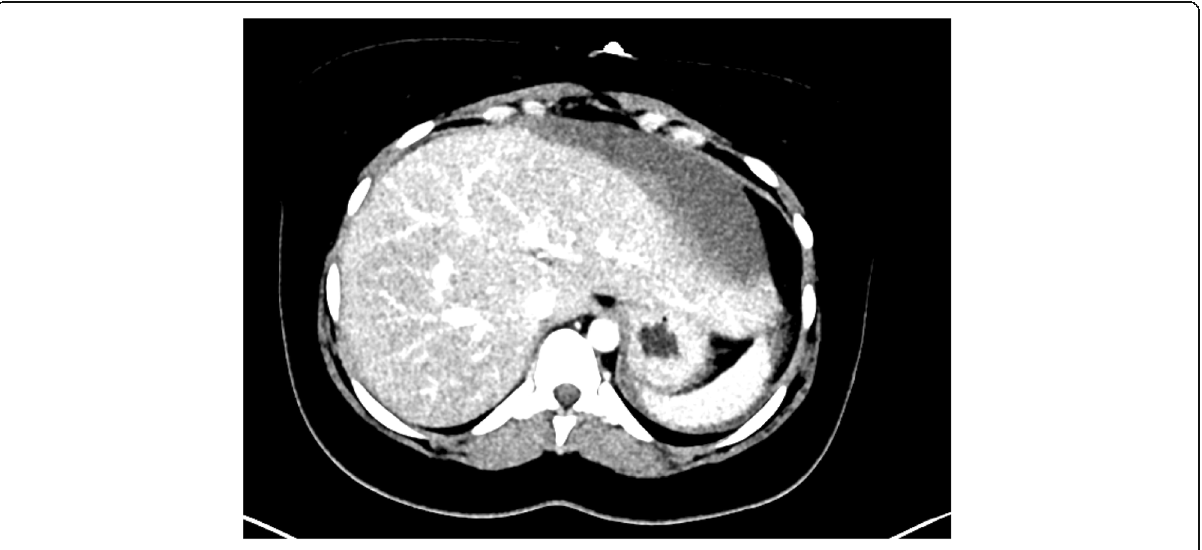
Fig. 1 Initial CT abdomen/pelvis (cross-sectional view)